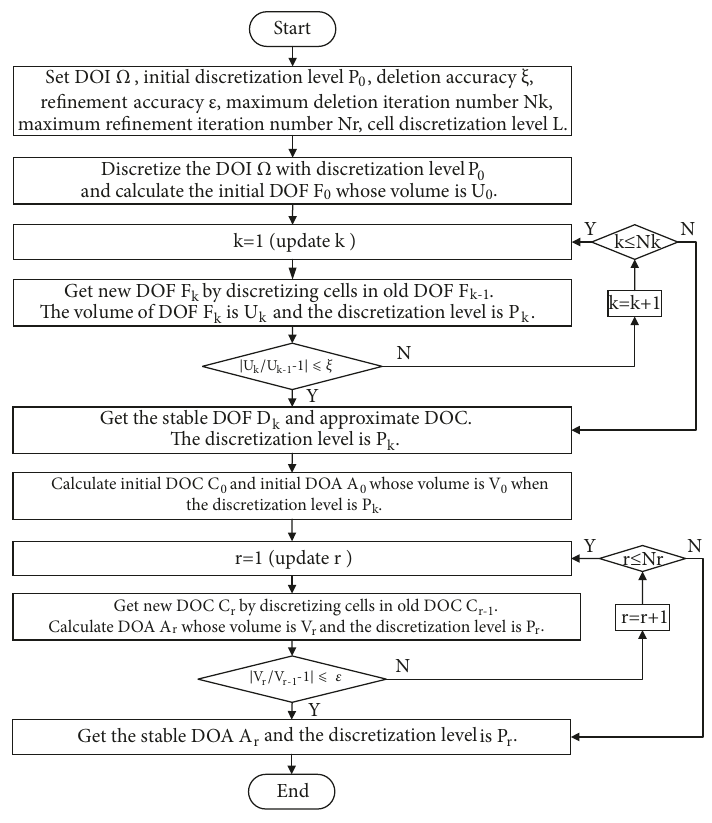
Figure 2: Flowchart of the MICM